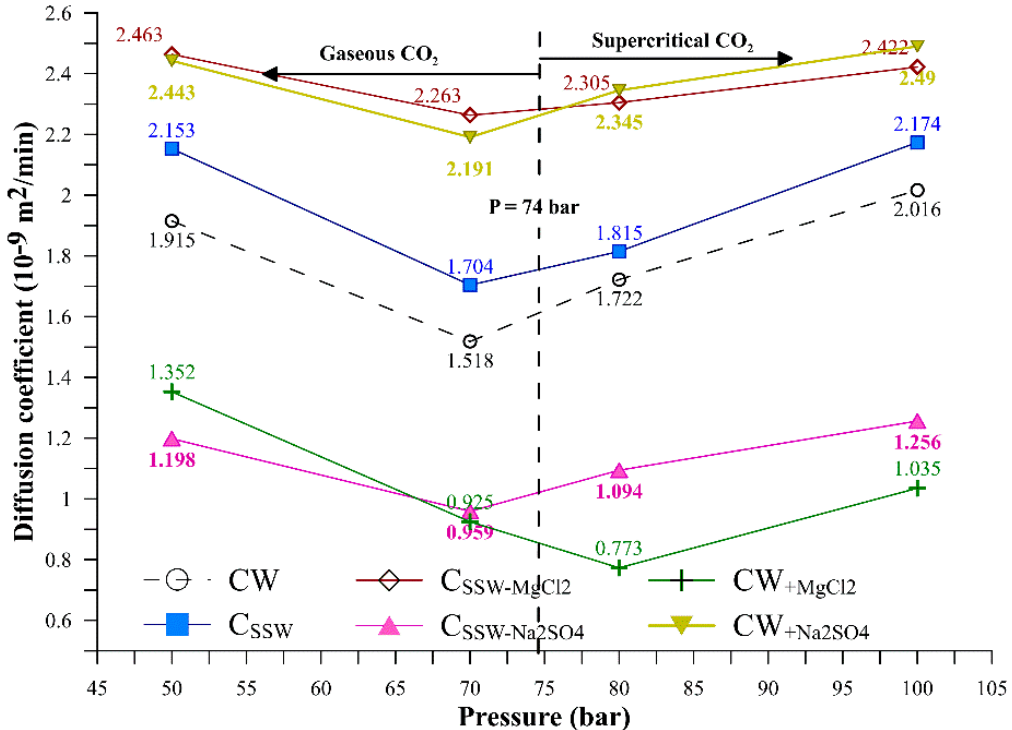
Figure 5. Effective diffusion coefficient of CO 2 into n-C10 from different CB and CW for pressures; 50, 70, 80, and 100 bar at 45 °C.